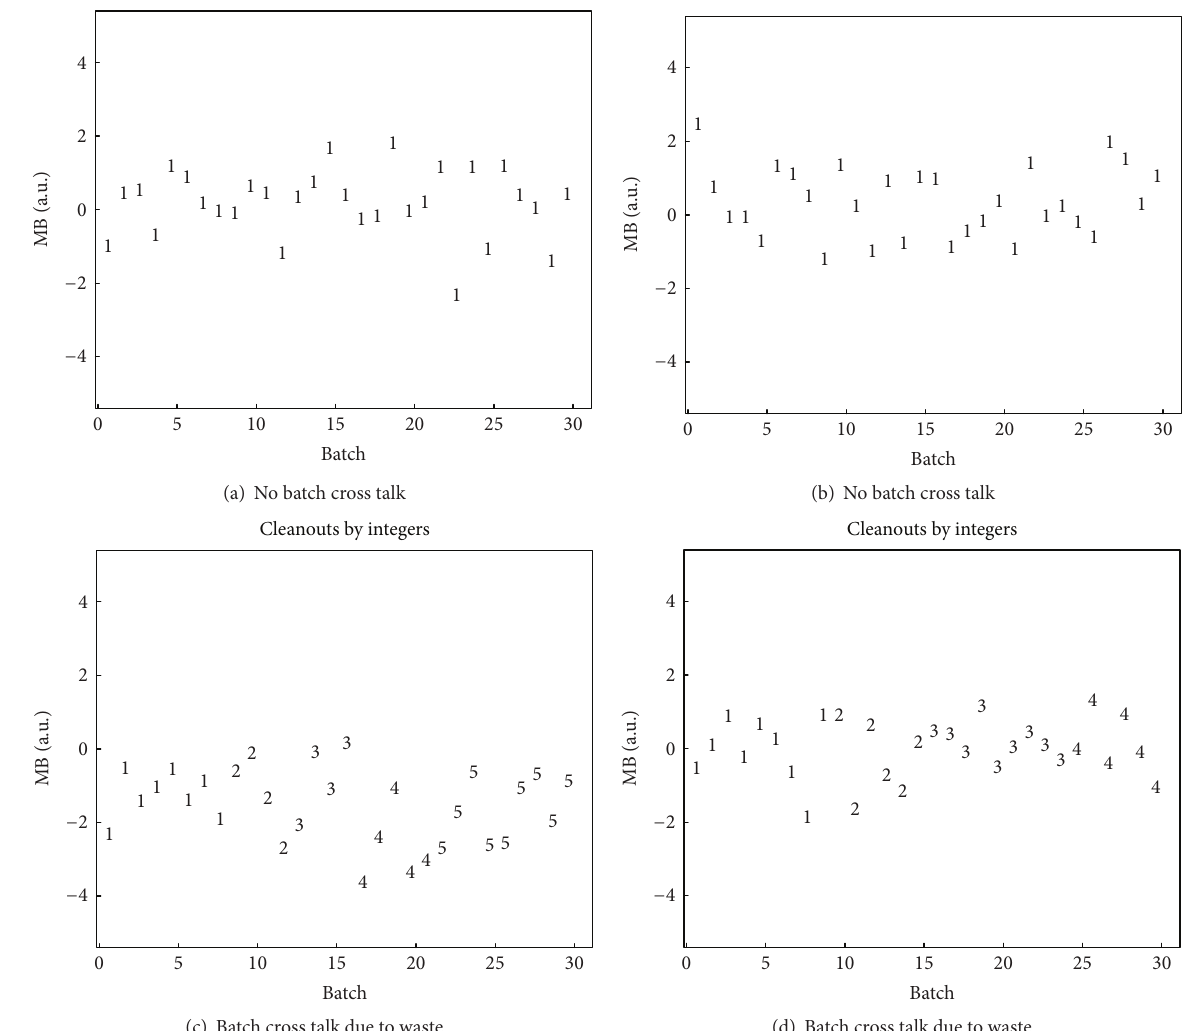
Figure 14: Simulated examples of MB sequences in arbitrary units (a.u.). In (a) and (b) there is no batch-to-batch cross talk and in (c) and (d) there is batch-to-batch cross talk. Plots (c) and (d) have batch-to-batch cross talk due to periodic cleanout of glove box waste.